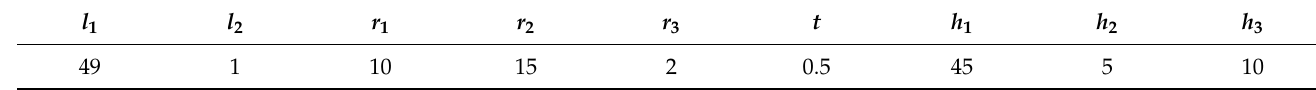
Table 1. The geometric parameters of the UAL